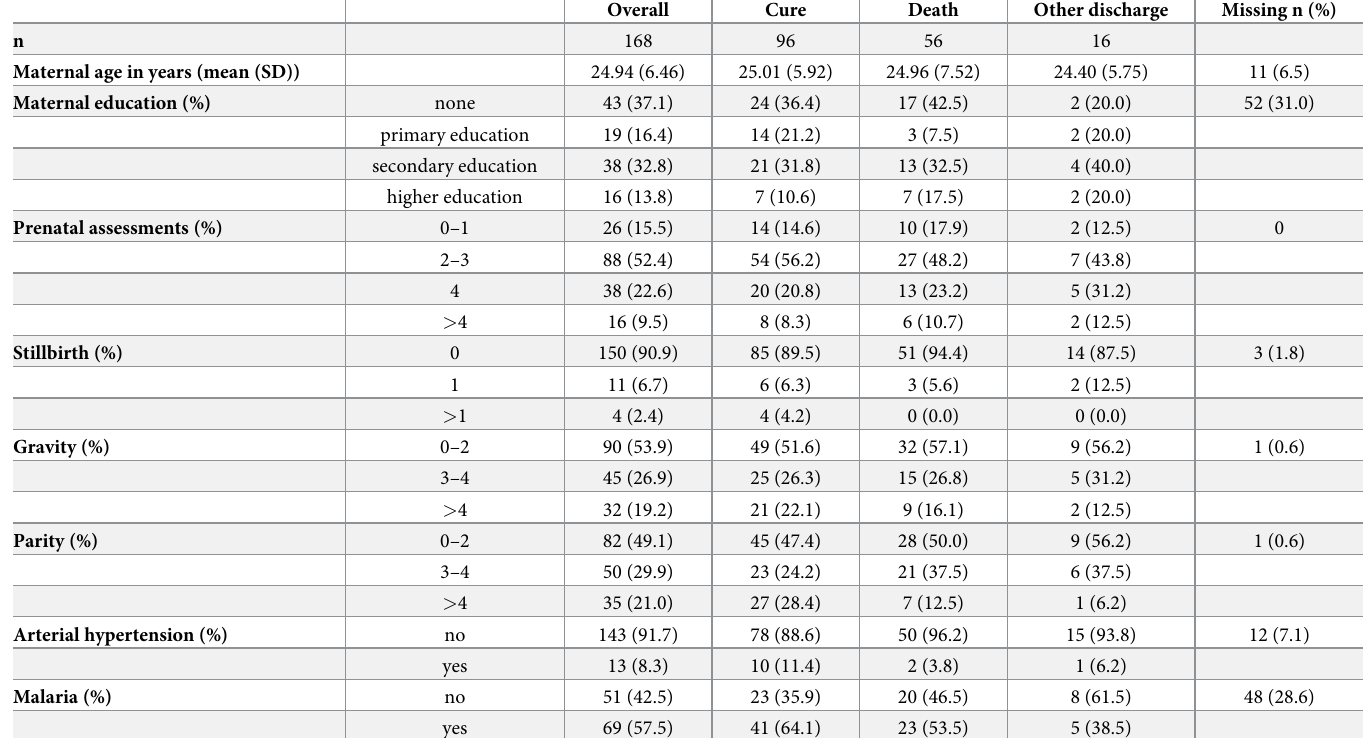
Table 3. The maternal anamnestic characteristics of newborns admitted to INSE for intensive neonatal care, stratified by neonatal outcome (cure or death during hospital stay or other